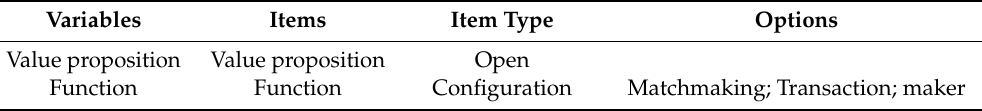
Table 5. Variables, items and configuration options for the “value proposition”